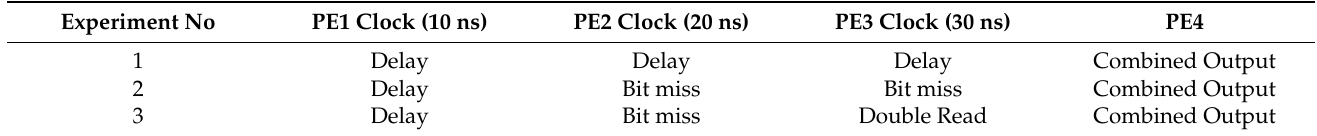
Table 3. Synchronization errors on three different interfaces.